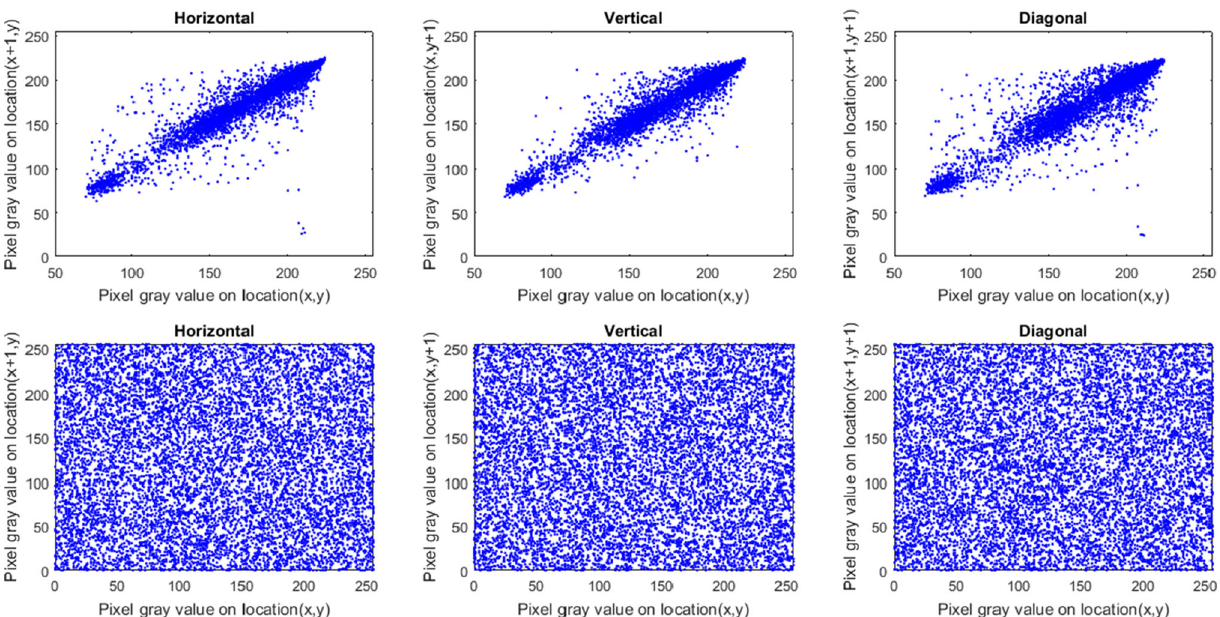
Fig. 6 Correlation distributions for blue component of Og01 image, in where the top row represents the distributions for the blue component of Og01 image, while the bottom row displays the distributions for the blue component of Cg01 image